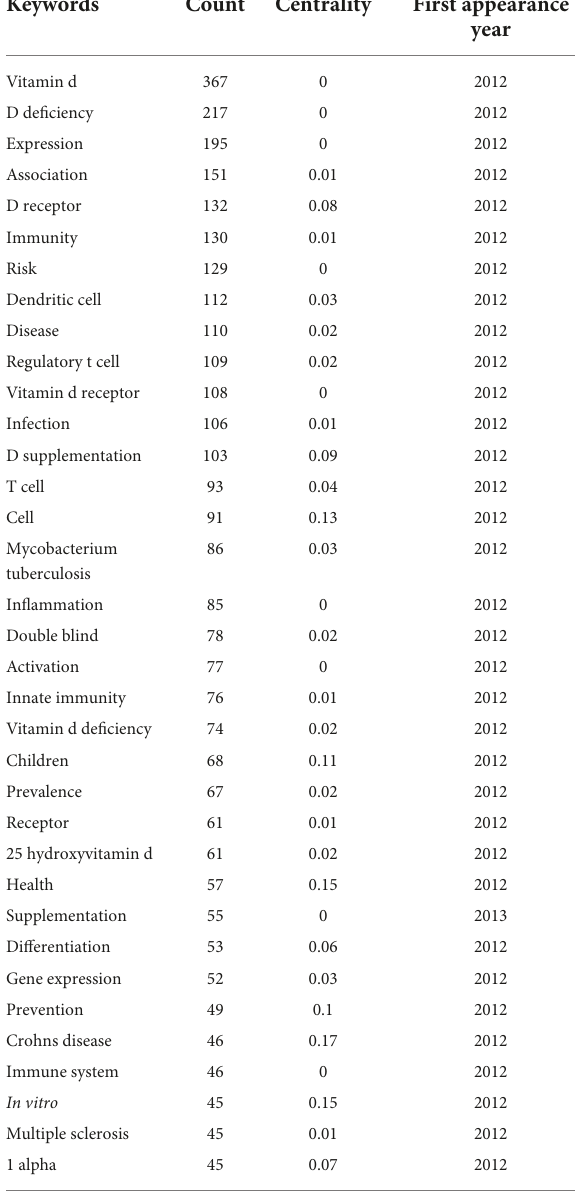
indicating the progression of hot topics. As illustrated in Figure 7 , a total of 48 keywords burst emerged from 2012 to 2021, with “induction” (7.61) having the highest